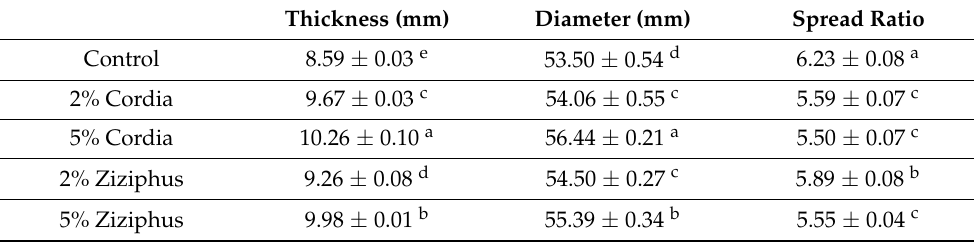
Table 3. Thickness, diameter and spread ration of the